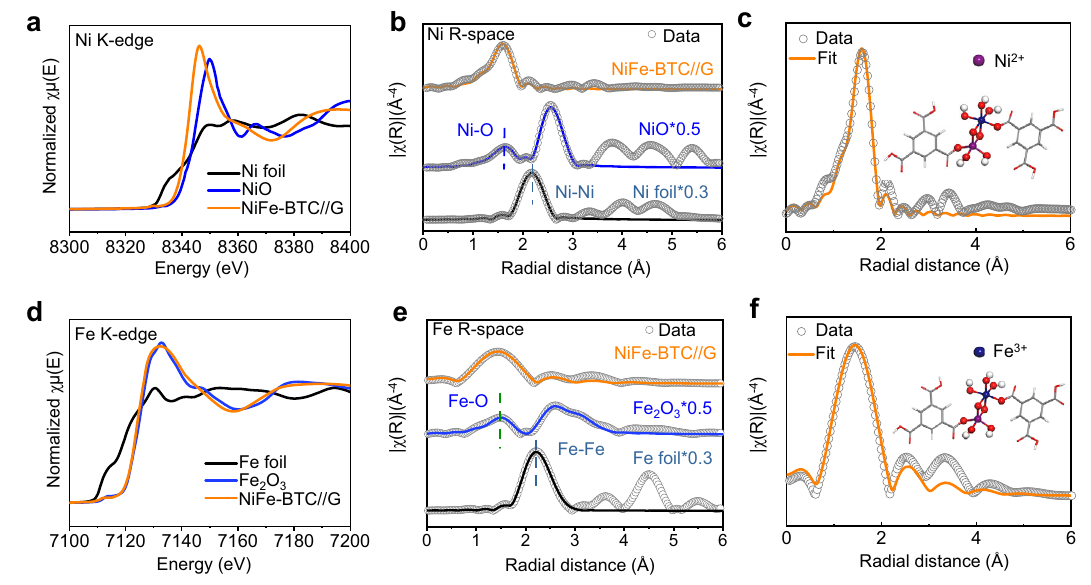
Fig. 3 | XANES,EXAFSand FT-EXAFSspectra.a NiK-edgeXANES and b extended XANESoscillation functions k 3 χ (k)with reference samples of Nifoil,NiO. c EXAFS fi tting curves in R space. Inset: related schematic model of Ni coordination envir- onment in NiFe-BTC//G. d Fe K-edge XANES and e extended XANES oscillation